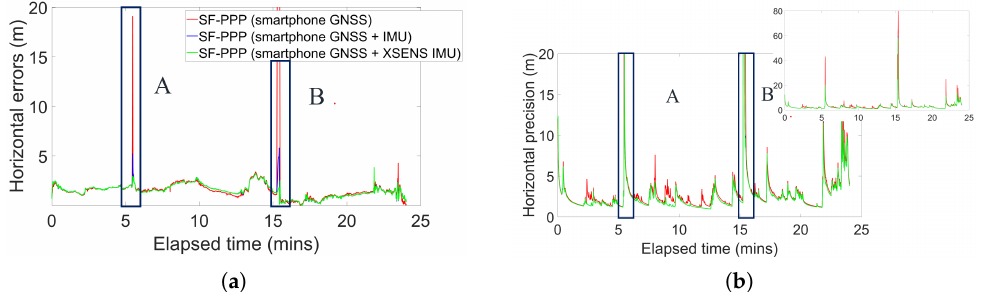
Figure 7. Horizontal error with respect to the reference trajectory and filter estimated precision com- parison for single-frequency PPP processing using smartphone GNSS measurements, GNSS + IMU measurements, and GNSS and Xsens IMU measurements. ( a ) Horizontal position error. ( b ) Horizontal precision